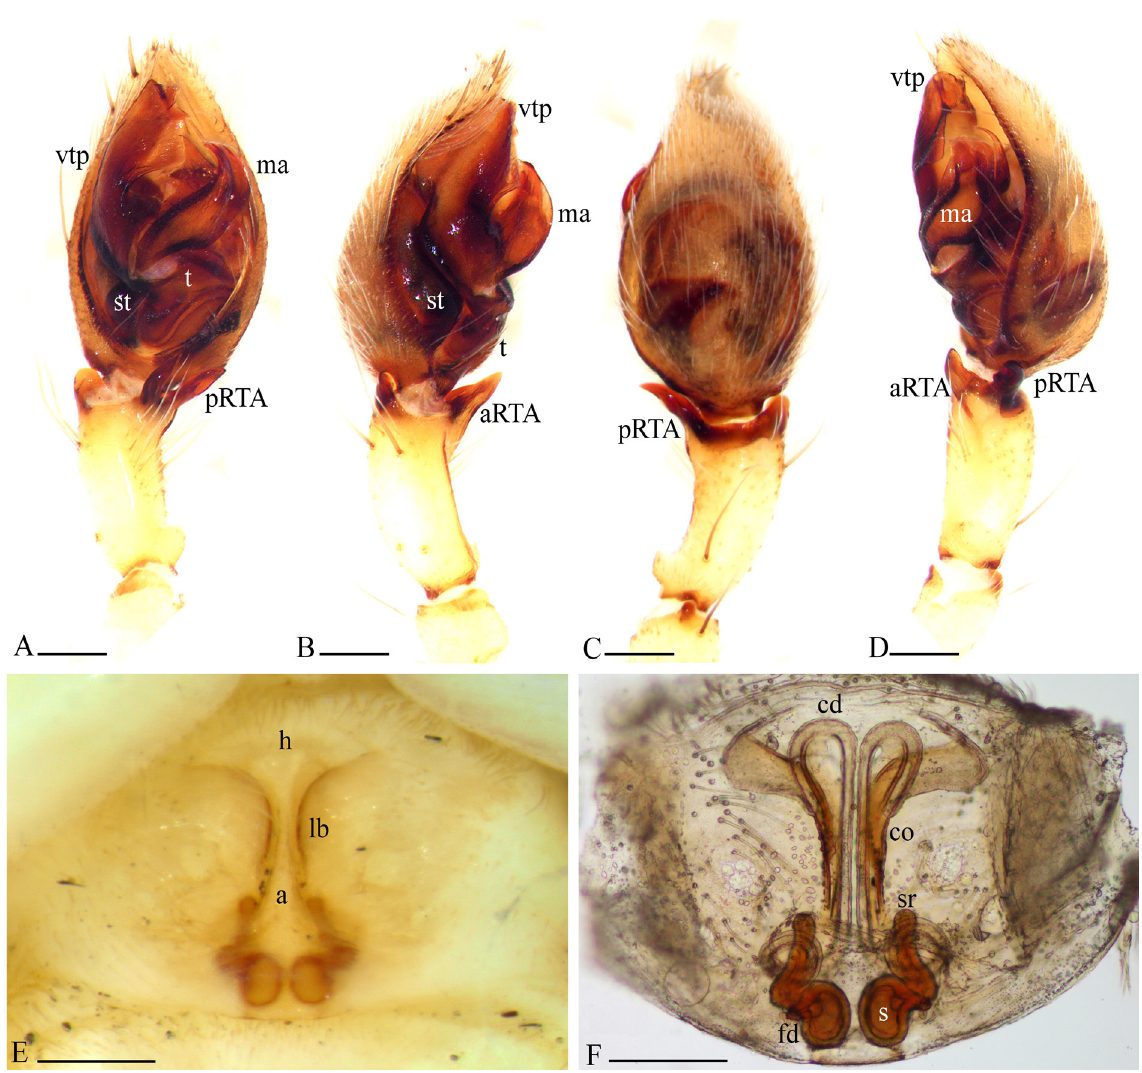
Fig. 40. Anyphaena porta sp. nov. A–D . Paratype, ♂ (CNAN-T01563). E–F . Paratype, ♀ (CNAN- T01565). A . Pedipalp, ventral view. B . Pedipalp, prolateral view. C . Pedipalp, dorsal view. D . Pedipalp, retrolateral view. E . Epigynum, ventral view. F . Epigynum, dorsal view. Scale bars: 0.2